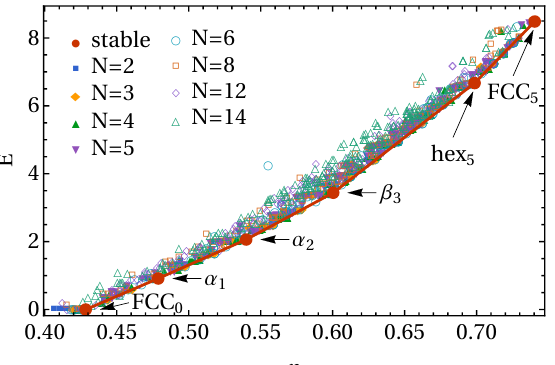
Figure 2. Candidate crystal structures for interaction range δ / σ = 0.2. Each point represents the density ρ and potential energy per unit volume E = β U σ 3 / V of the final structure in an independent floppy-box Monte Carlo simulation. Simulations were run with varying choices for the number of particles N , temperature, and pressure. Note that, for all stable structures, the same crystal was found from multiple independent